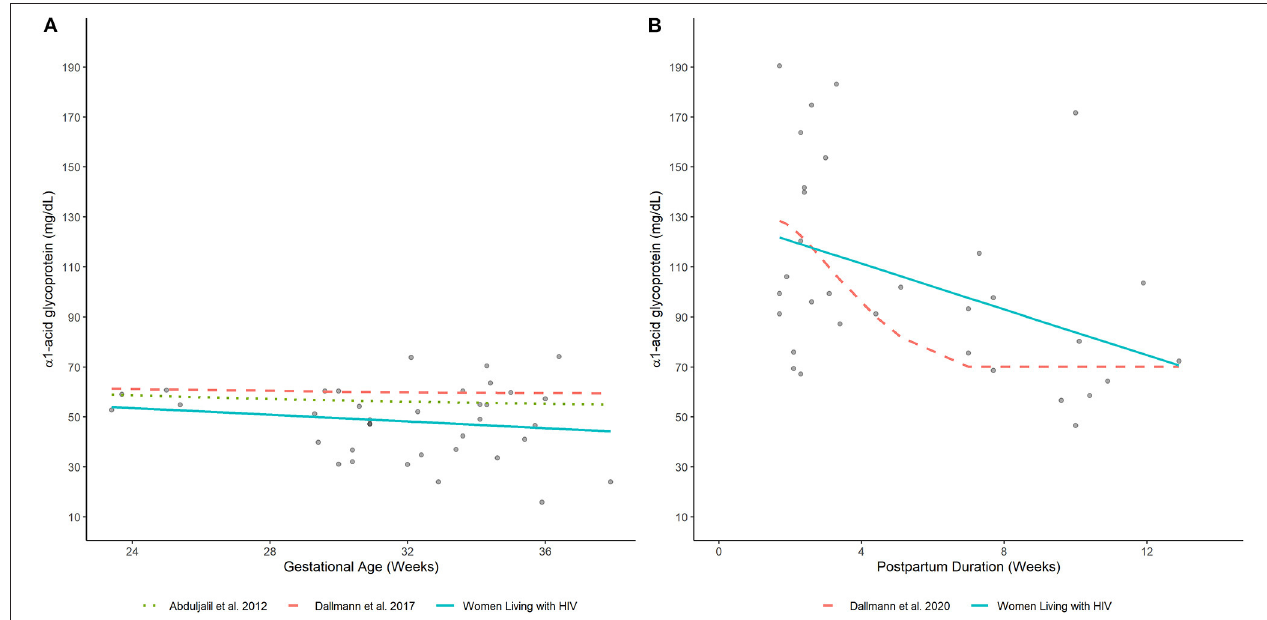
FIGURE 4 | Plasma AAG concentrations in (A) pregnant and (B) postpartum women estimated by our analysis (women living with HIV) and other published equations (women without HIV infection) ( 7, 8, 17). Lines depict (arithmetic) mean AAG concentration estimates generated by competing models. Filled-circles depict observed plasma AAG